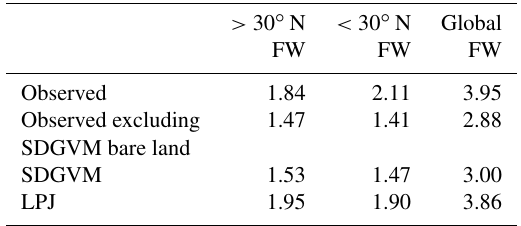
Table 2. Modern-day monthly mean FW area (10 6 km 2 ) for ob- served data interpolated to the 2.5 ◦ × 3.75 ◦ grid or calculated by vegetation